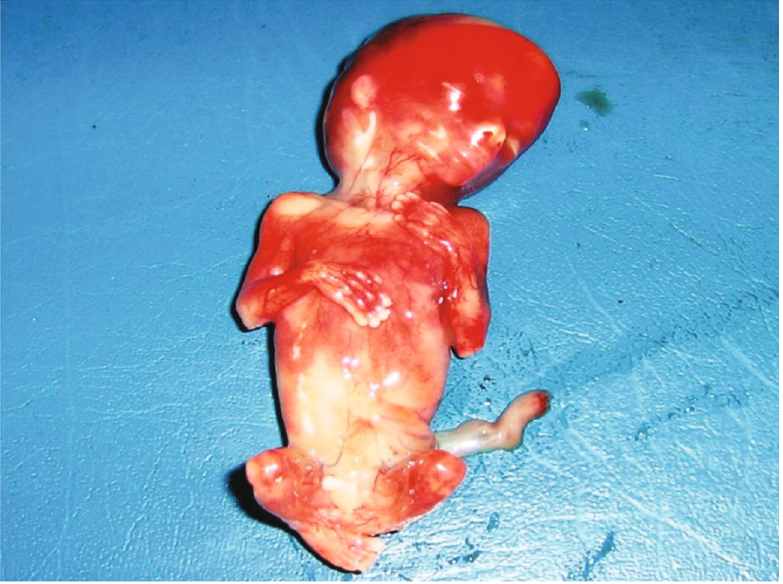
Figure 5: The stillborn fetus was male at 16 weeks of gestation, apparently